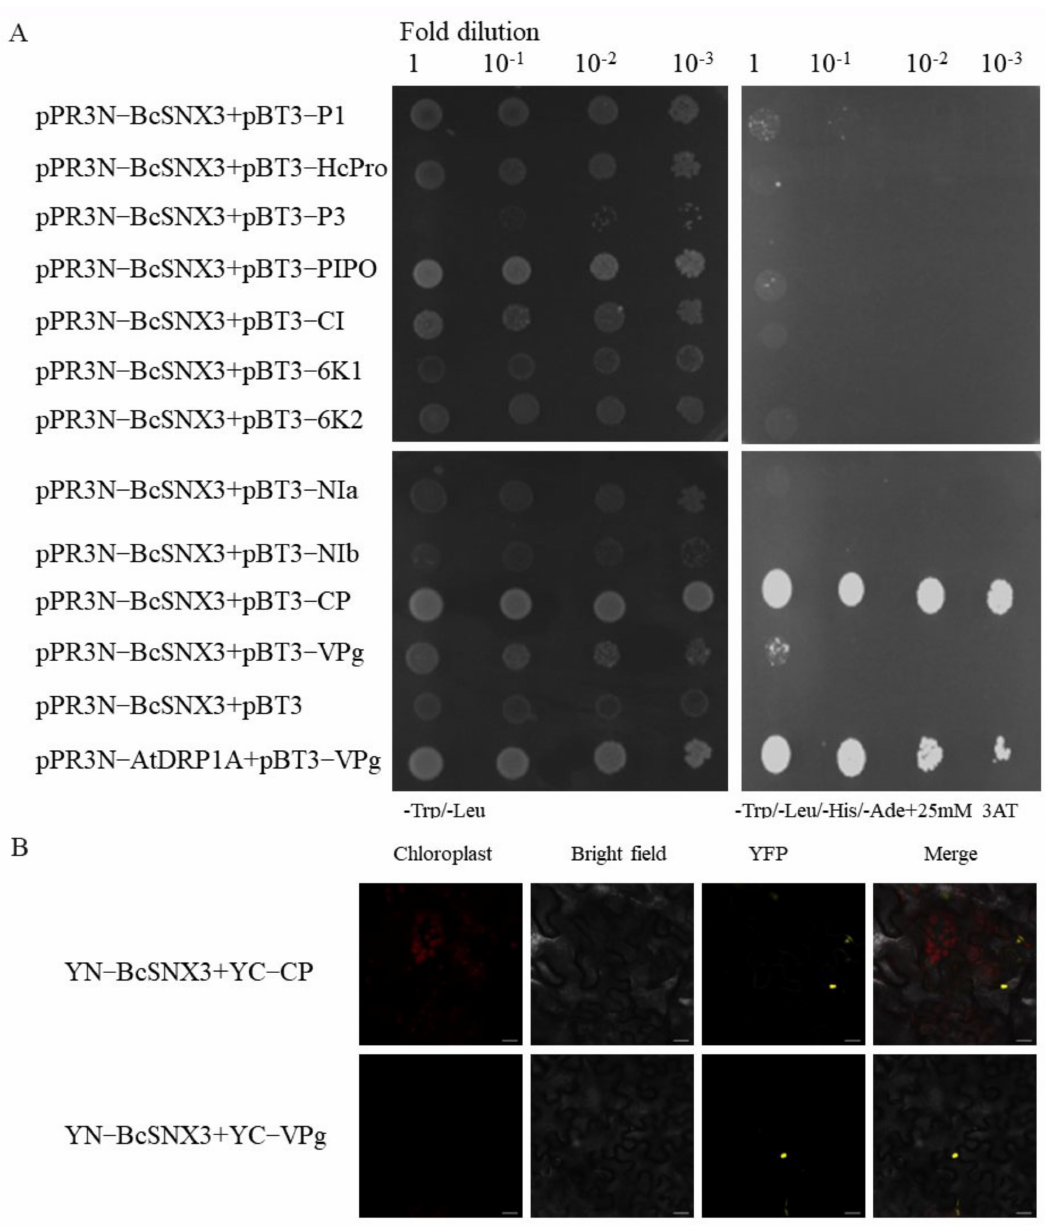
Figure 3. BcSNX3 interacts with CP and VPg. ( A ) Yeast-two hybrid (YTH) assays for possi- ble interactions between BcSNX3 and each of the 11 TuMV proteins. BcSNX3 and 11 viral pro- teins were fused with a GAL4 activation domain (pPR3N − BcSNX3) and a GAL4-binding domain (pBT3 − P1, pBT3 − HC-Pro, pBT3 − P3, pBT3 − PIPO, pBT3 − 6K1, pBT3 − CI, pBT3 − 6K2, pBT3 − NIa, pBT3 − NIb, pBT3 − CP, pBT3 − VPg) in turn. NMY51 yeast cells that were co-transformed with the indicated plasmids were subjected to 10-fold serial dilutions and plated on SD/-Trp, -Leu medium to screen for positive interactions at 3 days after transformation. Yeast co-transformed with pPR3N − AtDRP1A+pBT3 − VPg served as a positive control; yeast cells co-transformed with pPR3N − BcSNX3 and the empty pBT3 was a negative control. ( B ) BiFC assays between BcSNX3 on the one hand and CP and VPg on the other in the leaves of N. benthamiana . Confocal imaging was performed at 60-72 hpi. BcSNX3 was fused to the N-terminal fragments of yellow fluorescent protein (YFP)(YN), and CP and VPg were fused to the YC. The BcSNX3 − CP and BcSNX3 − VPg interaction led to the reconstituted fluorescence-competent structure and the restoration of yellow fluorescence. Bars, 20 µ